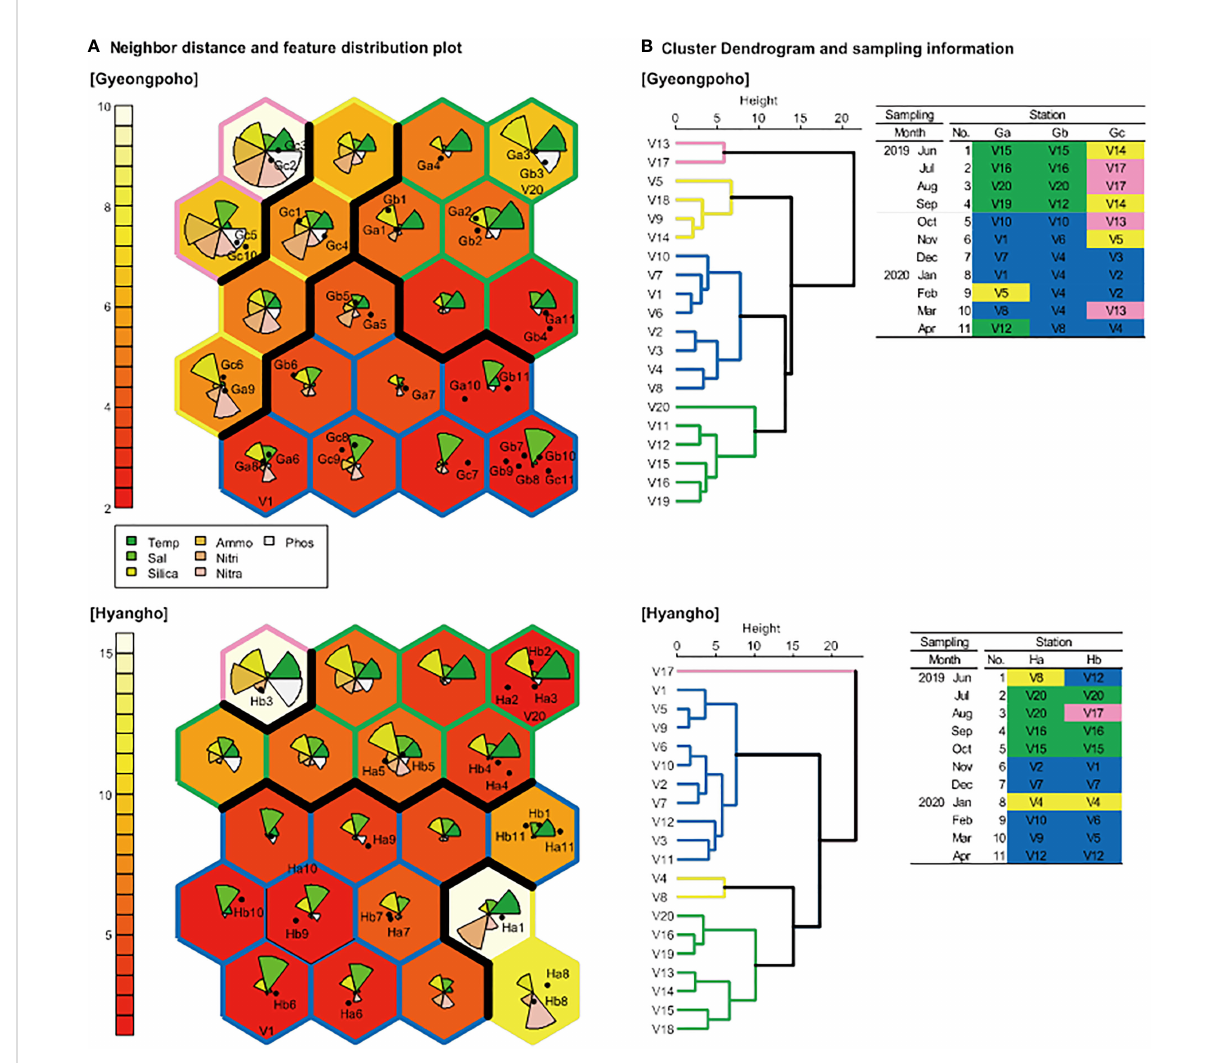
FIGURE 6 (A) Grouping of characteristics in study sites according to time and space on the Kohonen self-organizing map algorithm (SOM) trained with environmental factors. Gradient of unit box color (white-red) represents neighbor distance. Dendrogram of the trained SOM groups based on Ward ’ s linkage method and information table of individual samples (B)